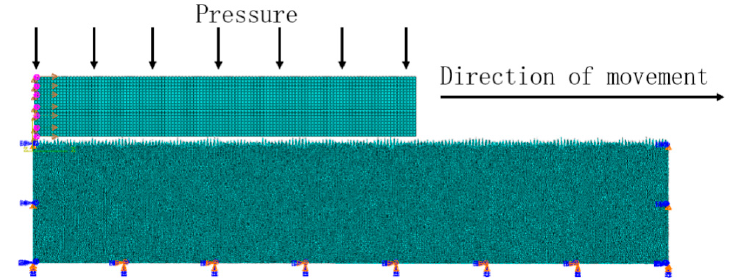
Figure 6. Fractal surface